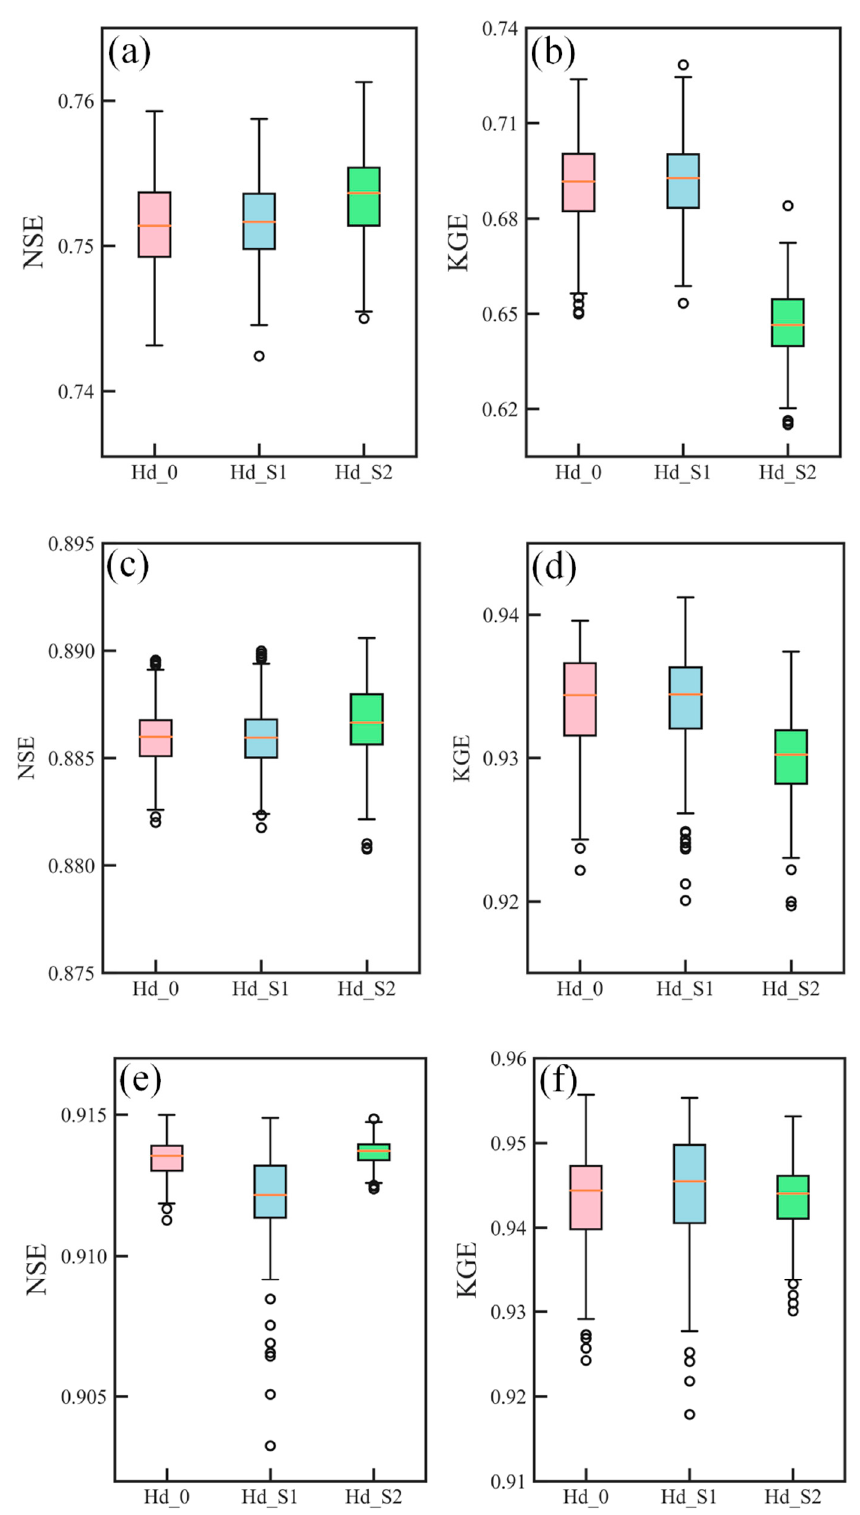
Figure 6. Boxplots of NSE / KGE values obtained by the three model setups during the validation period. For the Hanjiang River catchment ( a , b ), the Xiangjiang River catchment ( c , d ), and the Ganjiang River Catchment ( e , f ), the optimized parameter sets obtained from DREAM were used to perform all validation tests. The boxplots show the 0.1, 0.25, 0.5, 0.75, and 0.9 percentiles.